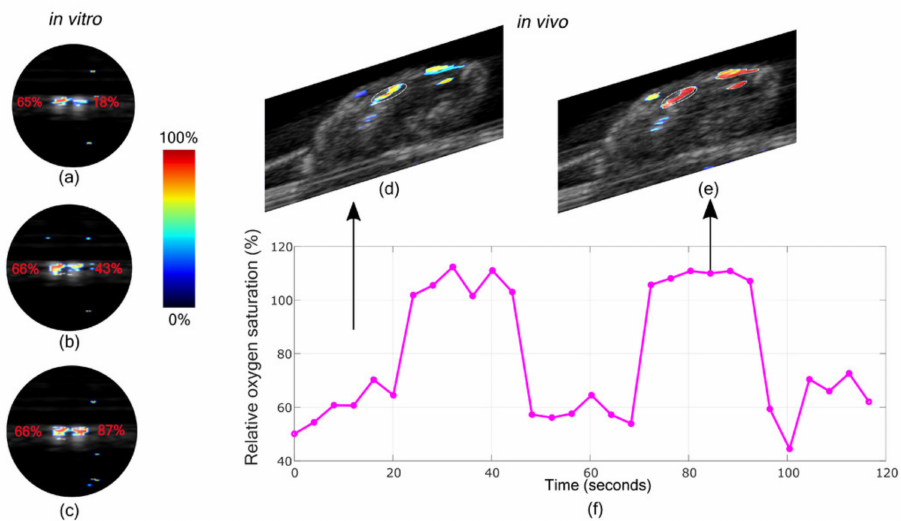
Figure 7. ( a – c ) The in-vitro study oxygen saturation map, with three di ff erent oxygen concentrations in the tube on the right, keeping oxygen unchanged in the left tube. The oxygen concentrations values in left and right tube: ( a ) 65% and 18%, ( b ) 66% and 43%, ( c ) 66% and 87%, ( d ) PA and ( e ) US imaging of mouse knee. In-vivo oxygen saturation images of mouse thigh muscle during high and low cycles of oxygen concentration. ( f ) Average oxygen saturation in the region of interested plotted over time. Reprinted from Ref.